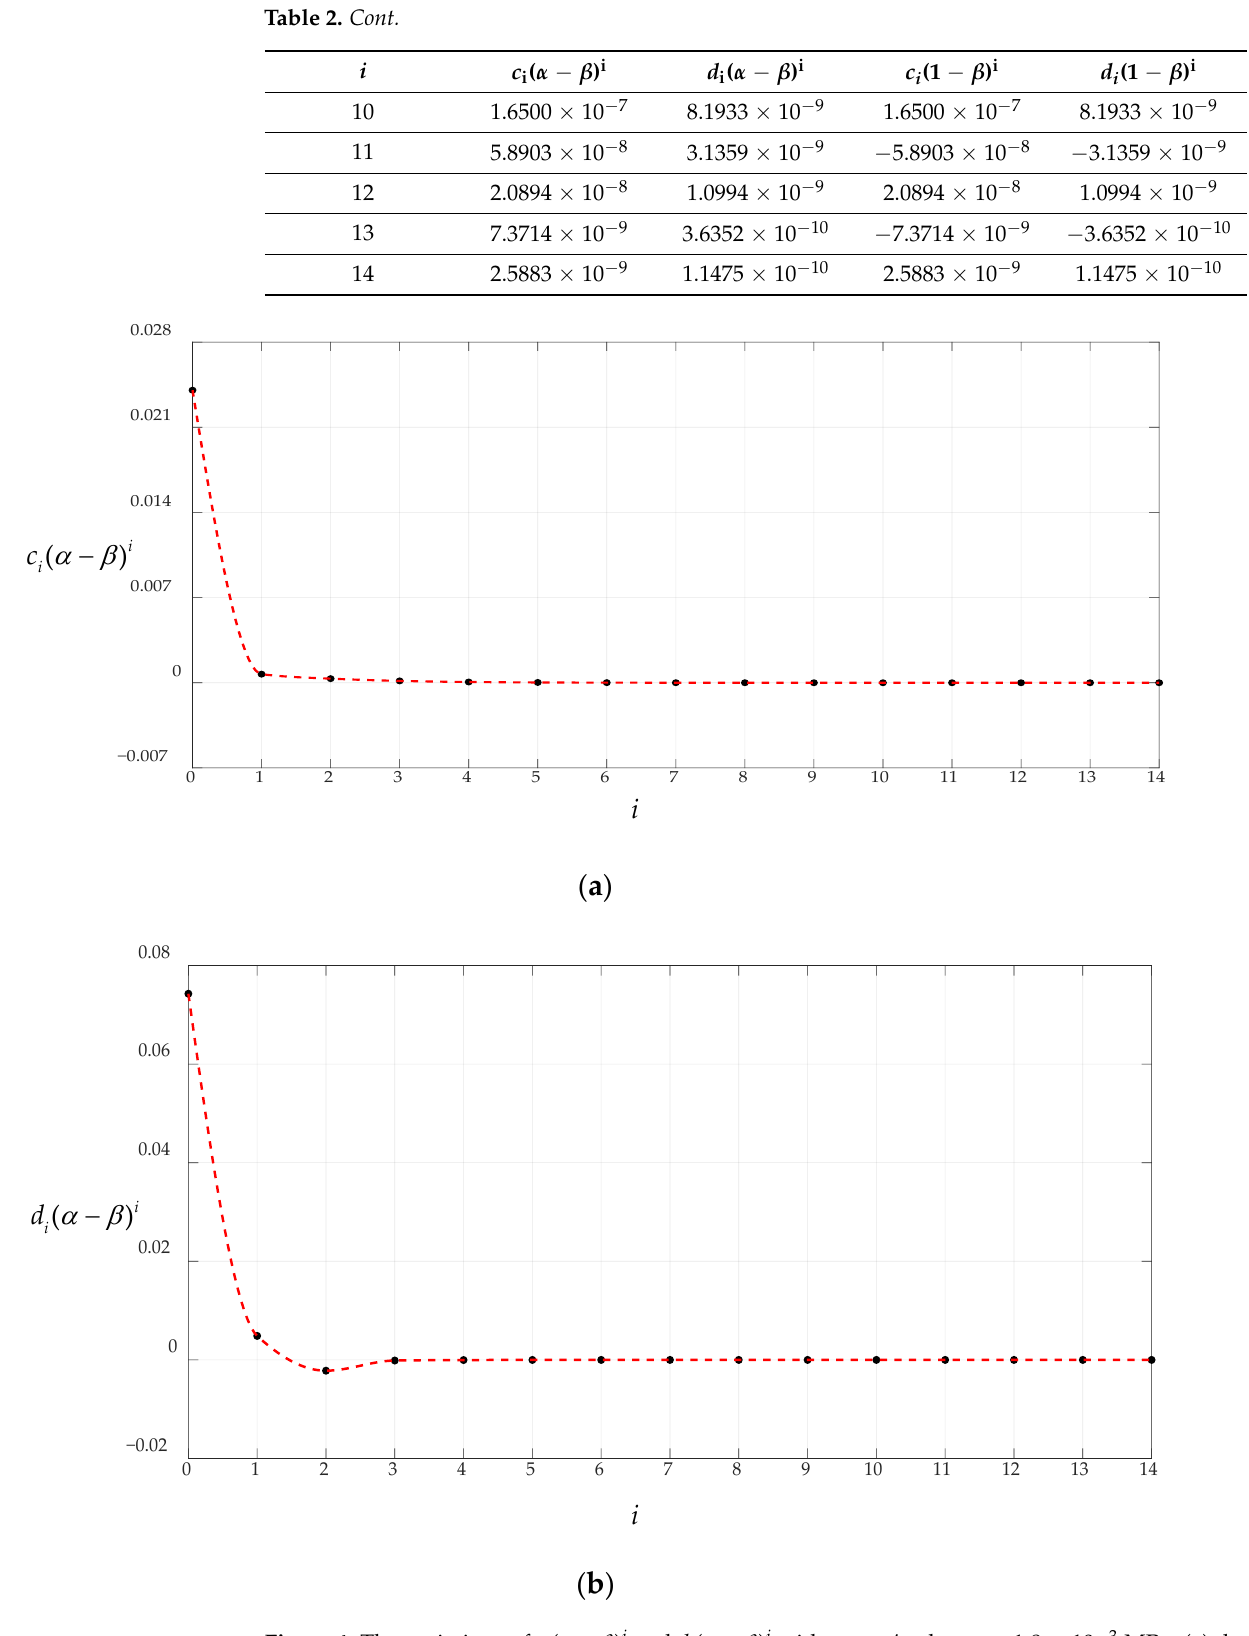
Figure 4. The variations of c i ( α − β ) i and d i ( α − β ) i with terms i , where q = 1.8 × 10 −3 MPa: ( a ) the variation of c i ( α − β ) i with i , and ( b ) the variation of d i ( α − β ) i with i .